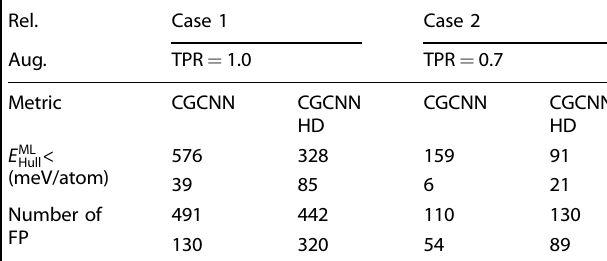
Table 1. Models ’ fi ltering performance.